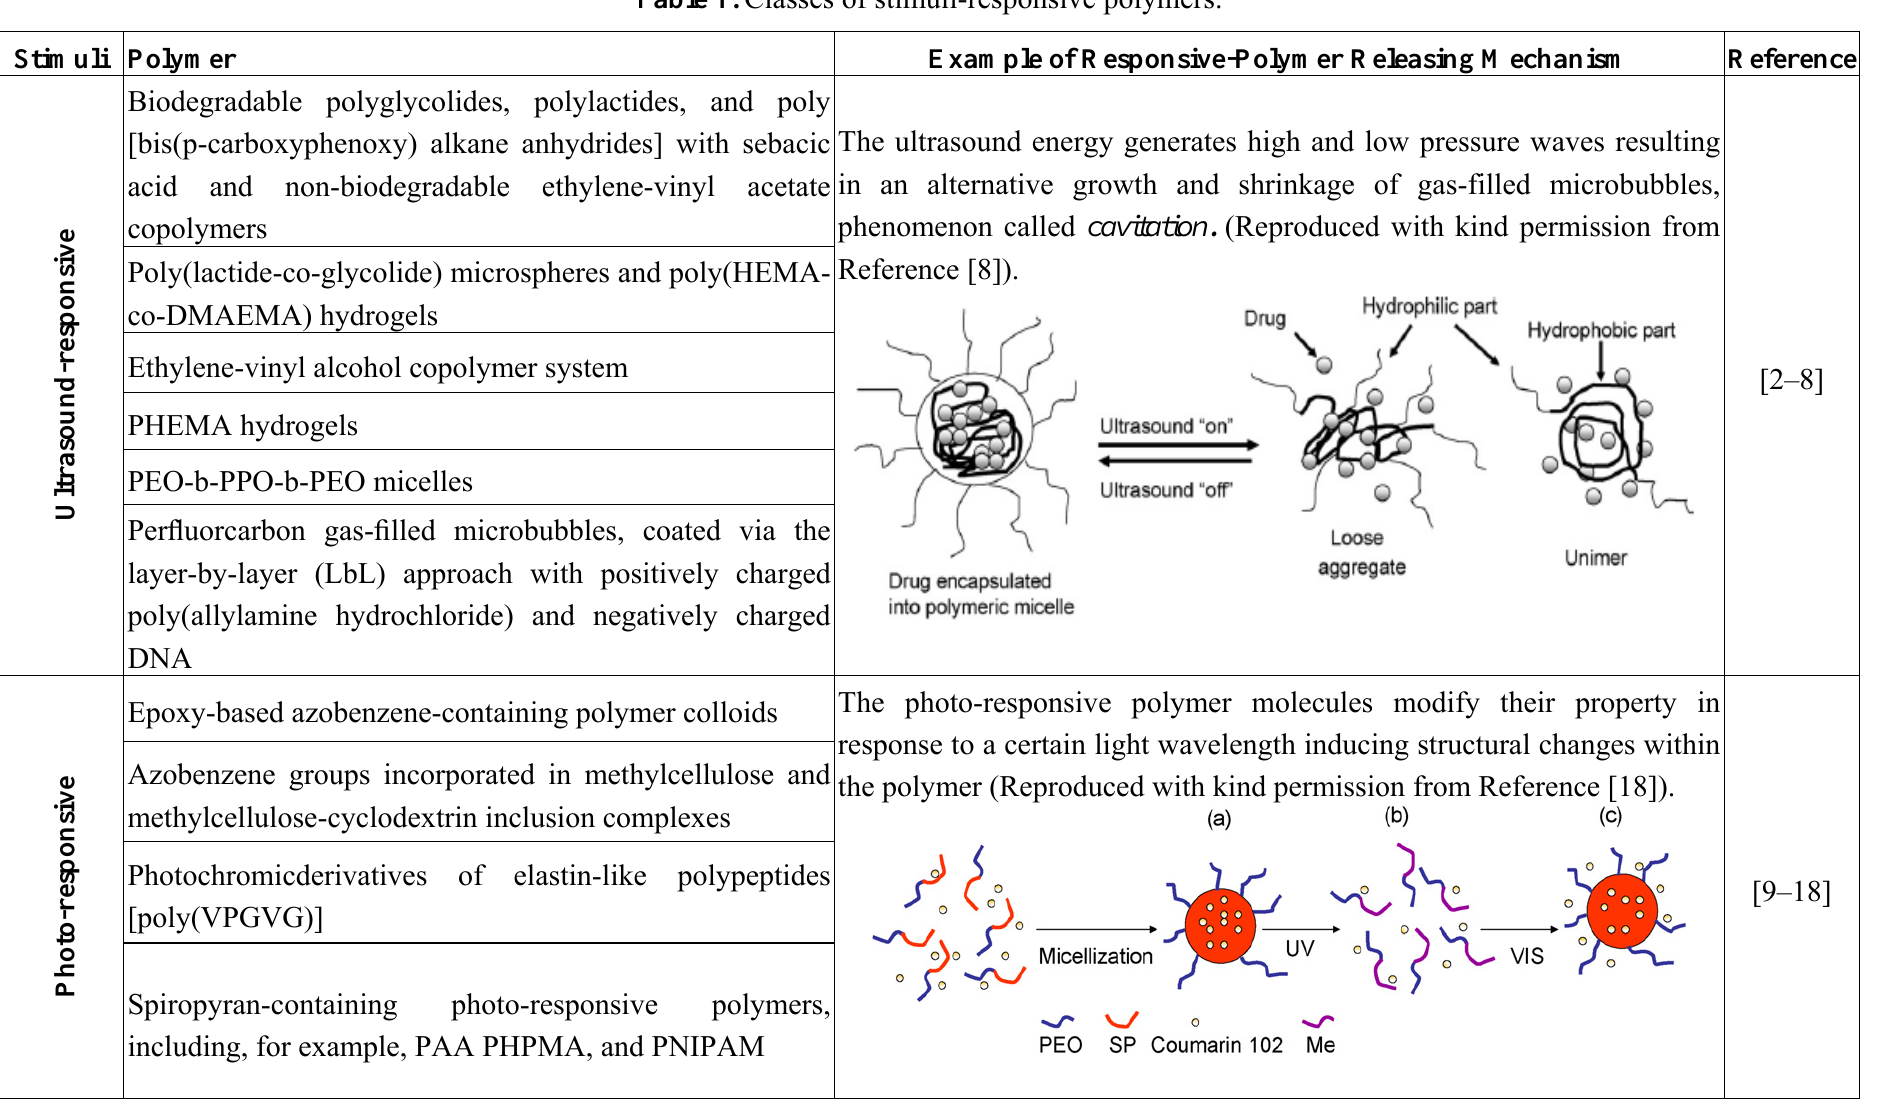
Table 1. Classes of stimuli-responsive